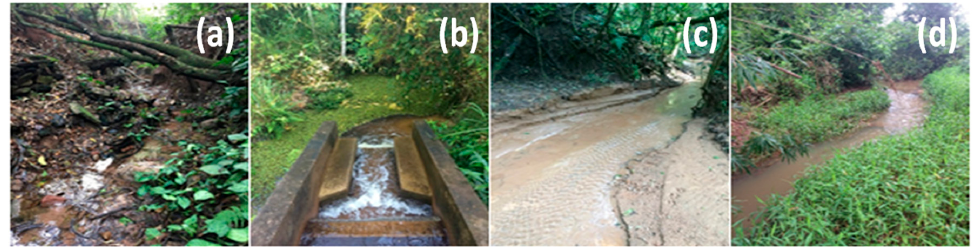
Figure 4. Location of discharge flow monitoring points: ( a ) sub-basin 1.1; ( b ) sub-basin 1.2; ( c ) sub-basin 2; ( d ) sub-basin 3.